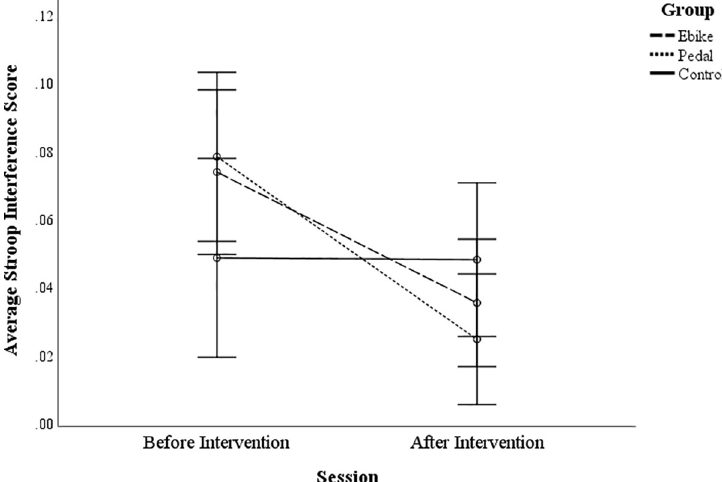
Fig 1. Stroop interference score for the non-cycling controls, E-bike cyclists and pedal cyclists before and after the intervention. Error bars are +/- 2 SEs.